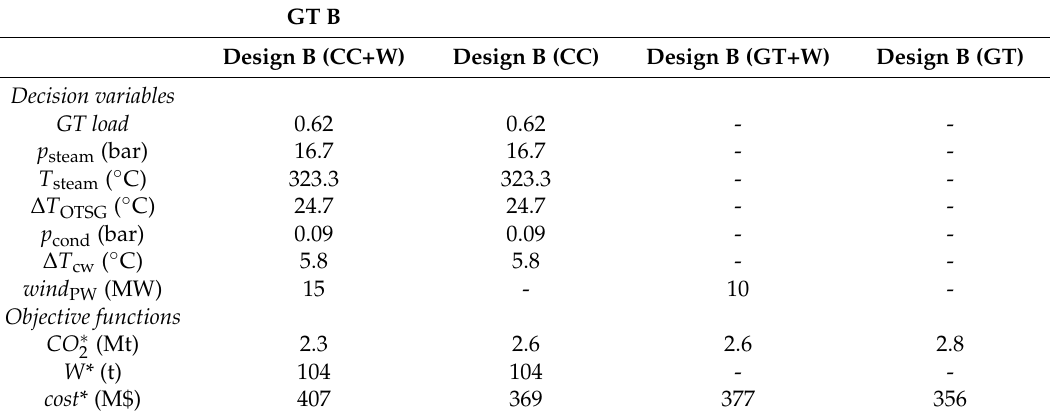
Table 5. Characteristics of the optimal designs selected based on a GT